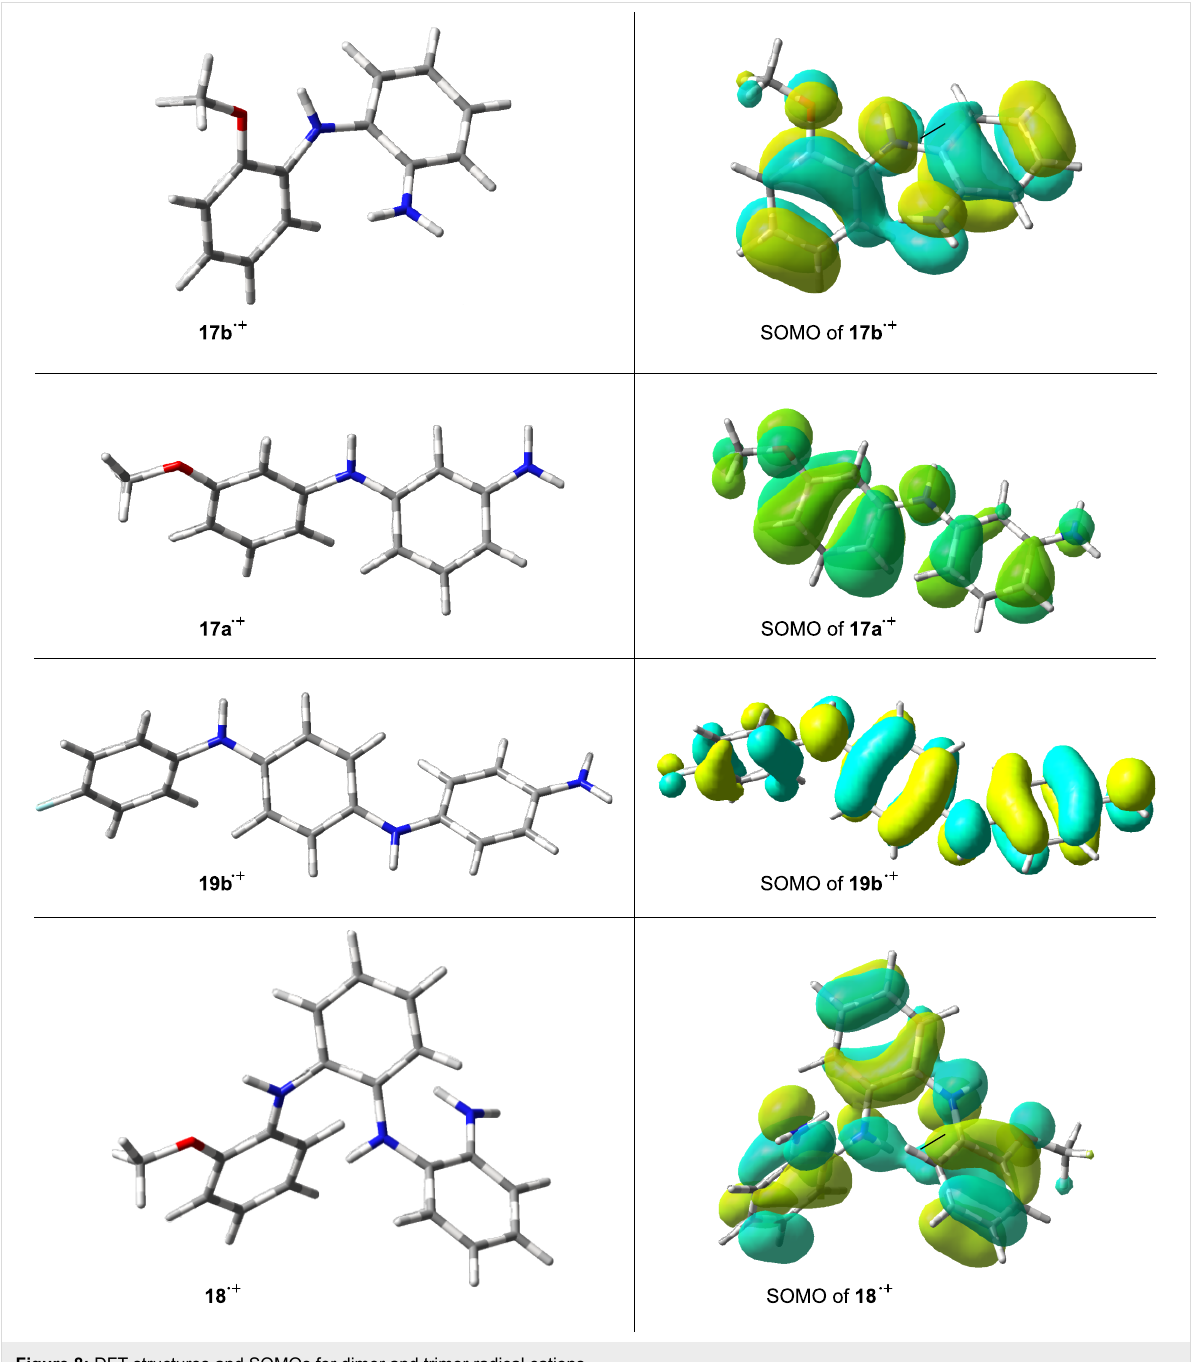
Figure 8: DFT structures and SOMOs for dimer and trimer radical